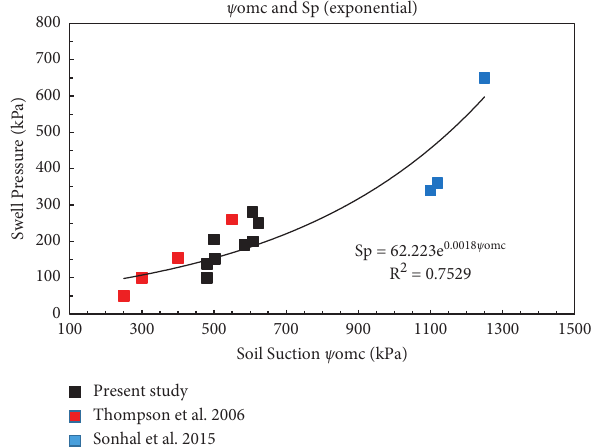
Figure 6: Presentation of suction-based exponential relation for swell pressure.